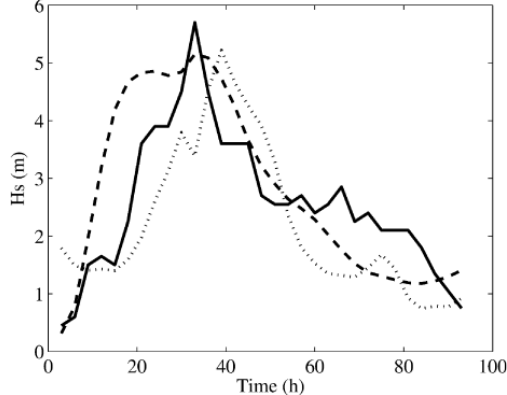
Fig. 7. A typical wave storm shape from the observed H s data (solid line) and numerical simulations with two different wind forcings (dashed line: COSMO-CLM; dotted line: